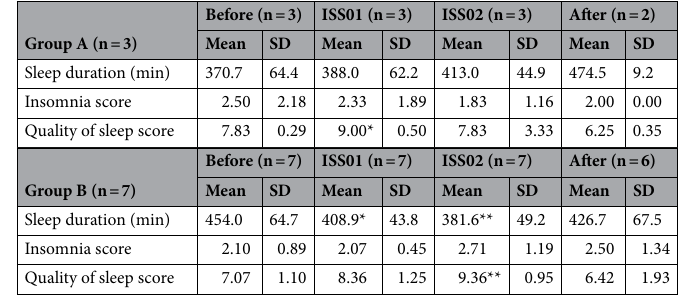
Table 2. Change in sleep duration, insomnia, and quality of sleep scores during spaceflight. Paired t-test; * P < 0.05, ** P < 0.01 (vs. Before, same Group).